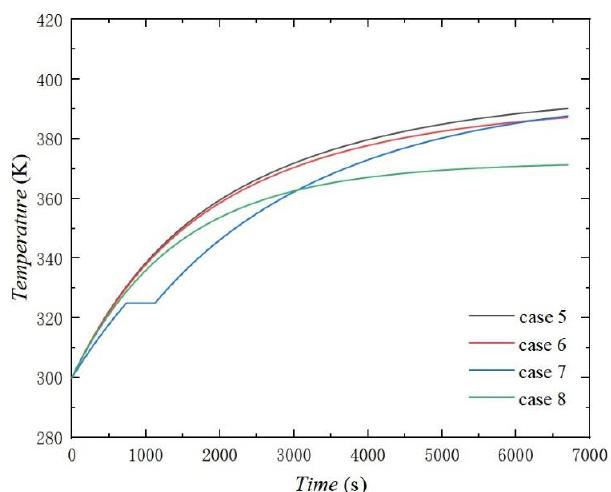
Figure 18. Temperature of accessory 1 when the casing and accessory were thermally protected.